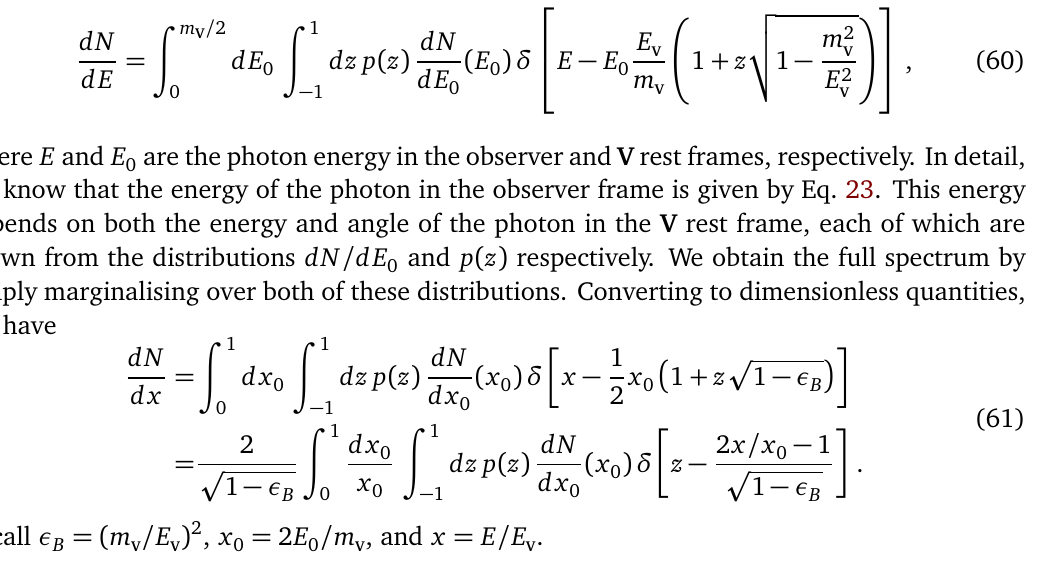
Figure 17: Left: the evolution of the dark-to-visible temperature ratio τ ≡ T a function of T , for τ using an iterative approach. Right: the evolution of 1 /τ vs T of